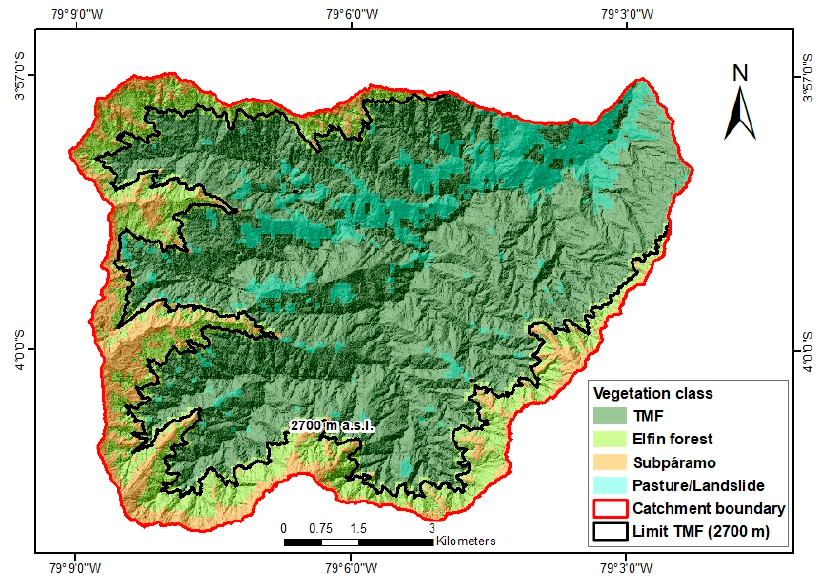
Figure 11. Land cover map in the San Francisco catchment obtained from the CHM (resolution 1 ha × 1 ha).